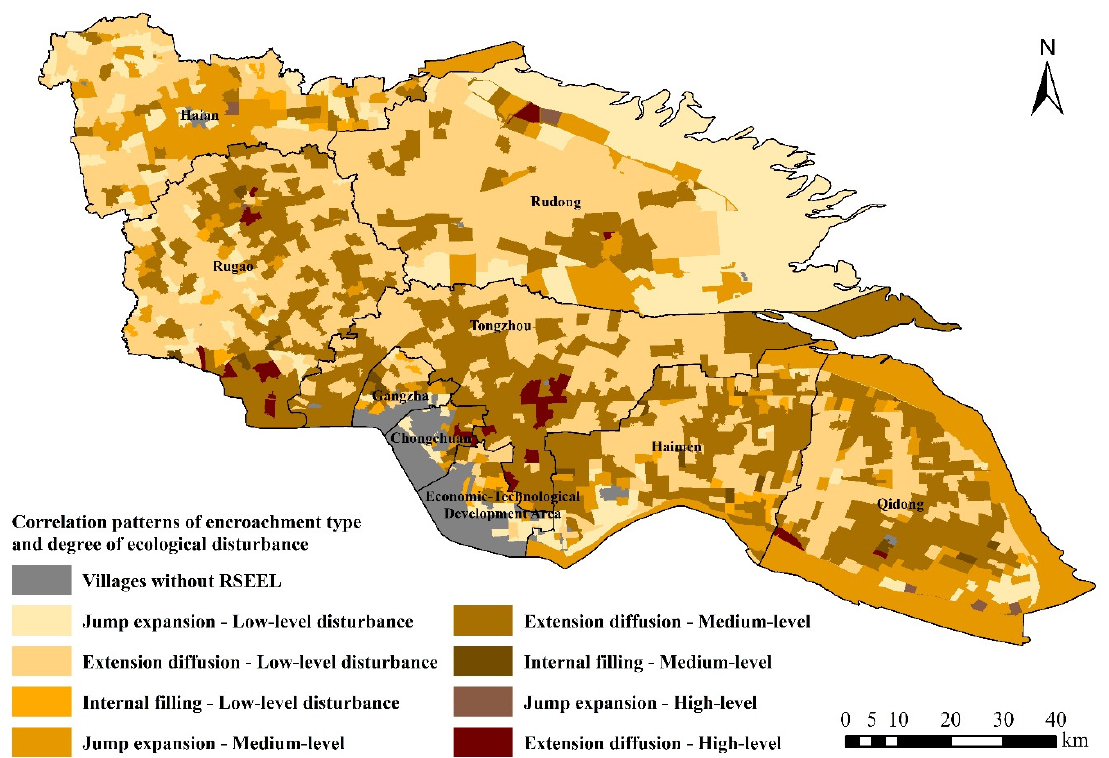
Figure 10. Correlation patterns of encroachment type and degree of ecological disturbance in RSEEL at the village level in Nantong.